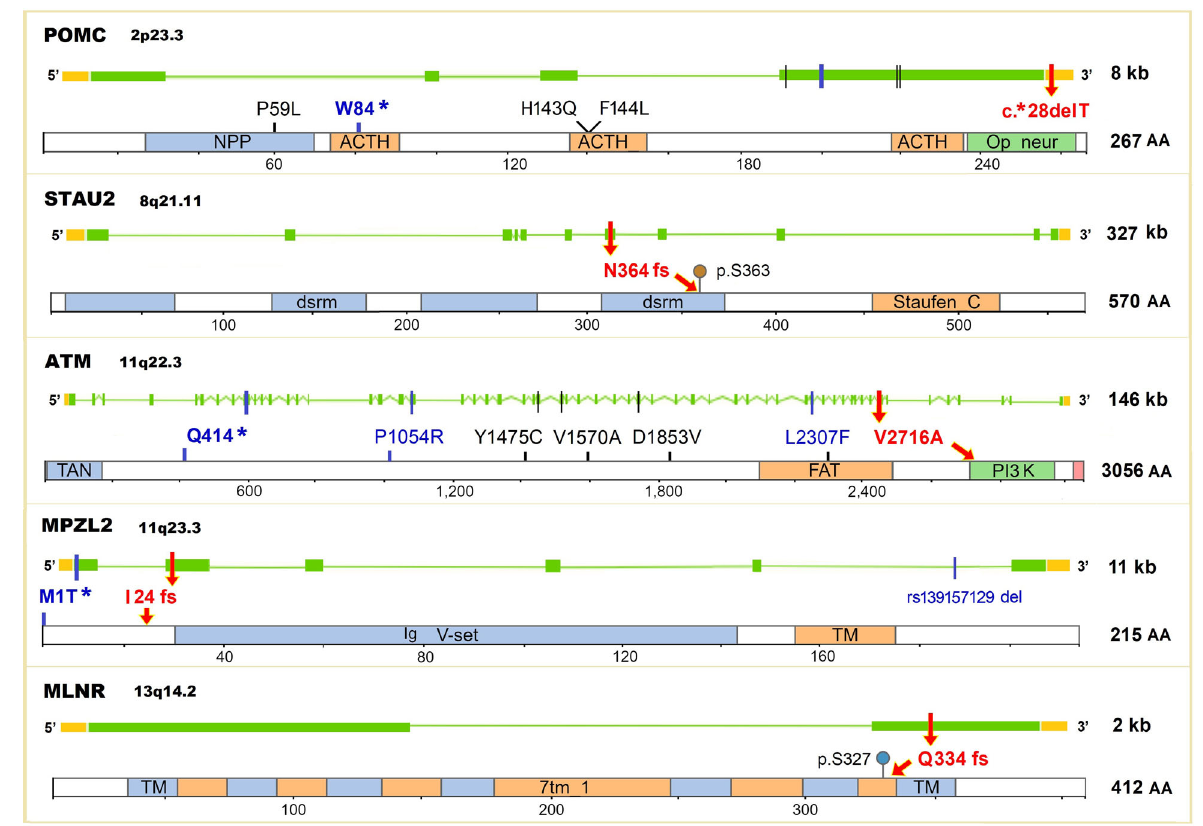
Fig. 1 Gene exons, protein domains, and rare deleterious variants of the candidate genes. The top fi ve candidate variants (red arrows): 1) POMC c.*28 deletion (del) located at target sites of several miRNAs in 3 ′ UTR; 2) STAU2 p.N364M fs*67del located in the double-stranded RNA- binding motif (dsrm), and next to a phosphorylation site p.S363; 3) ATM V2716A located in the PI3-kinase (PI3K) catalytic domain; 4) MPZL2 p. I24M fs*22del was close to the antibody variable domain of immunoglobulins (Ig-V); 5) MLNR p.Q334V fs*3del located in the transmembrane receptor domain (TM), and close to a phosphorylation site p.S327. The color vertical bars represent different types of variants: ClinVar pathogenic variants (bold blue: POMC W84* stop-gain, ATM Q414* stop-gain, and MPZL2 M1T* start-loss), previous reported LC-associated variants (blue: ATM P1054R and L2307F, and MPZL2 deletion rs13915729), and ClinVar variants of uncertain signi fi cance (black). Gene exons (green blocks), introns (horizontal green lines), untranslated regions (UTRs, orange blocks), and protein domain/motif (framed rectangles) are shown. The length of the gene (kb) and protein (number of amino acids, AA) are shown to the